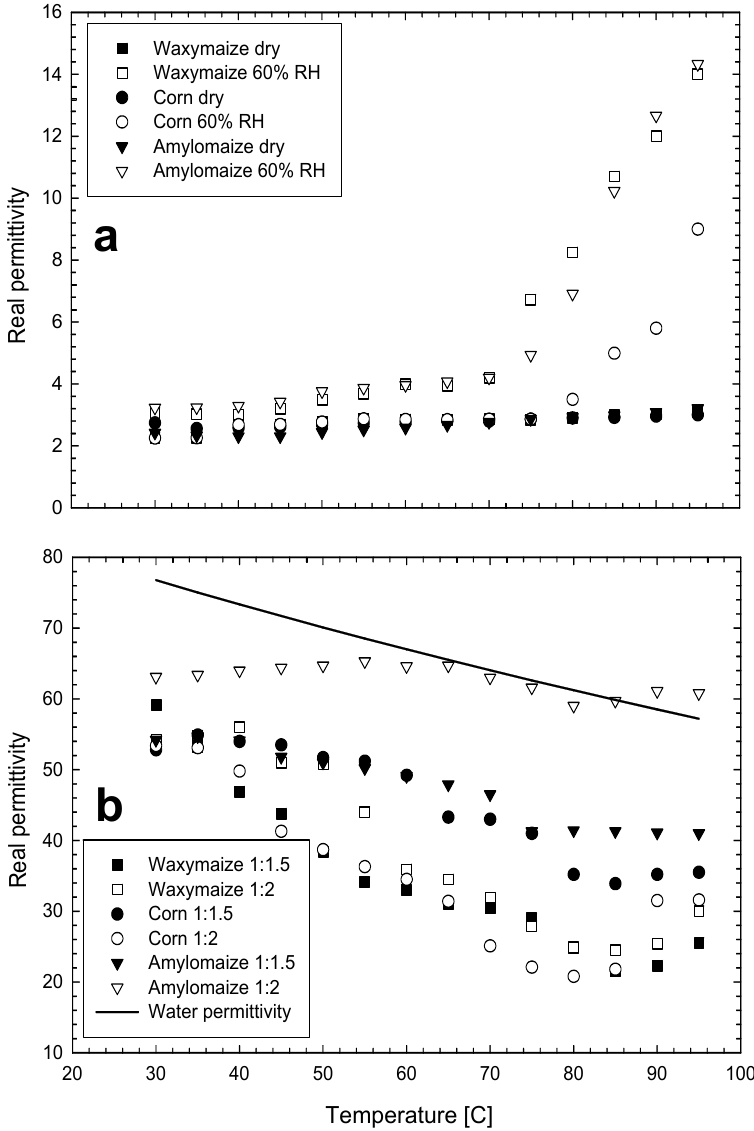
Figure 4. Real permittivity of three different varieties of corn starch at different moisture contents measured at 2.45 GHz (digitized from [73]). Bound water-dominated starch ( a ) shows an increase in the dielectric constant, ε ’, with increasing temperature while free water-dominated starch ( b ) exhibits a decrease in ε ’ with temperature increase. Free water permittivity shown for reference.